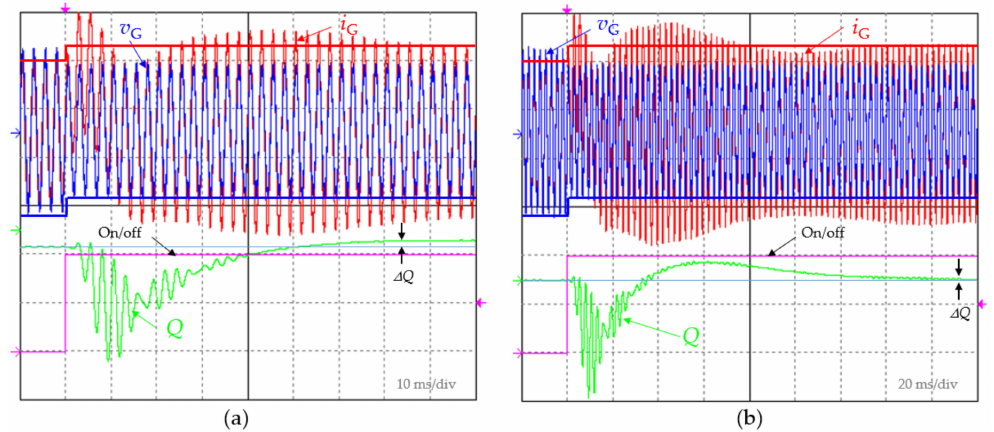
Figure 12. Grid voltage sag of 20%: ( a ) waveforms of the grid voltage v G and grid current i G , the reactive power Q , the signal identifying a voltage sag. On/off recorded for the standard grid converter; ( b ) waveforms of the grid voltage v G and grid current i G , the reactive power Q , the signal identifying a voltage sag. On/off recorded for the proposed grid converter with a reactive power compensation.